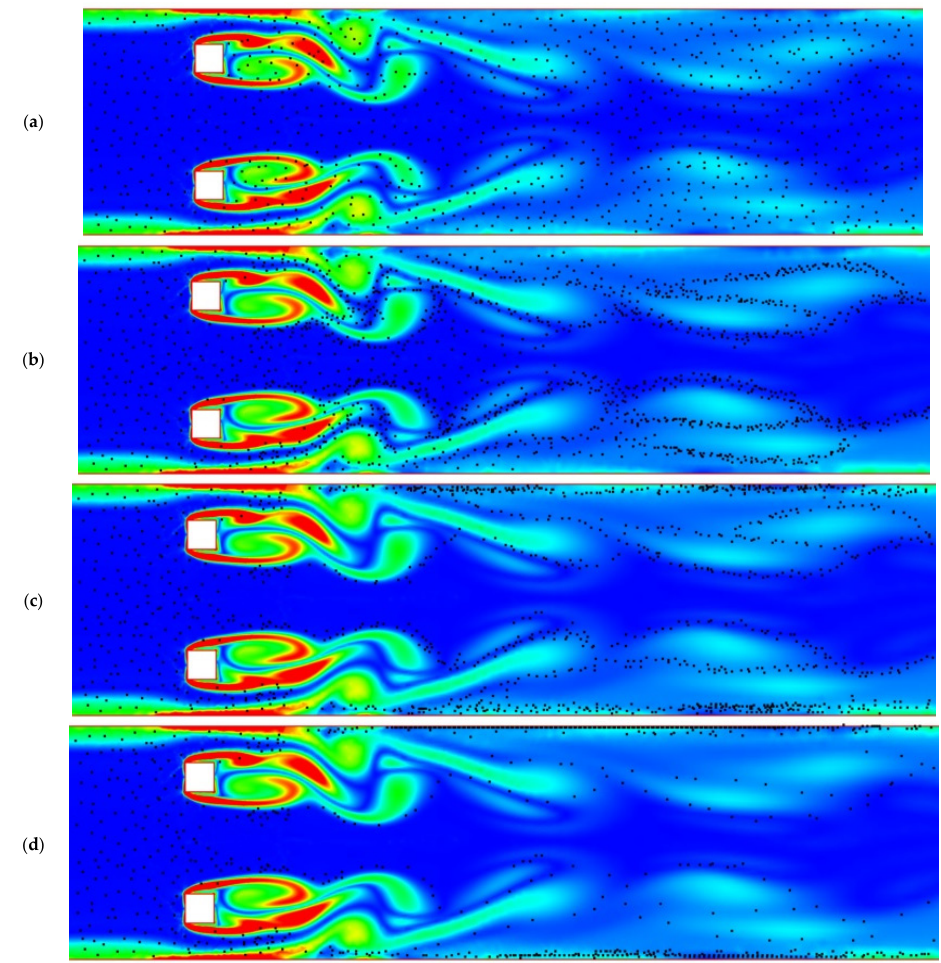
Figure 5. Dispersion of the particles inside the duct for ( a ) dp = 30 nm; ( b ) dp = 0.1 µ m; ( c ) dp = 0.25 µ m; ( d ) dp = 0.5 µ m at Re = 100, S/D = 3.5, and Φ = 0.01. It is observed that the concentrations of particles for all values of space ratio